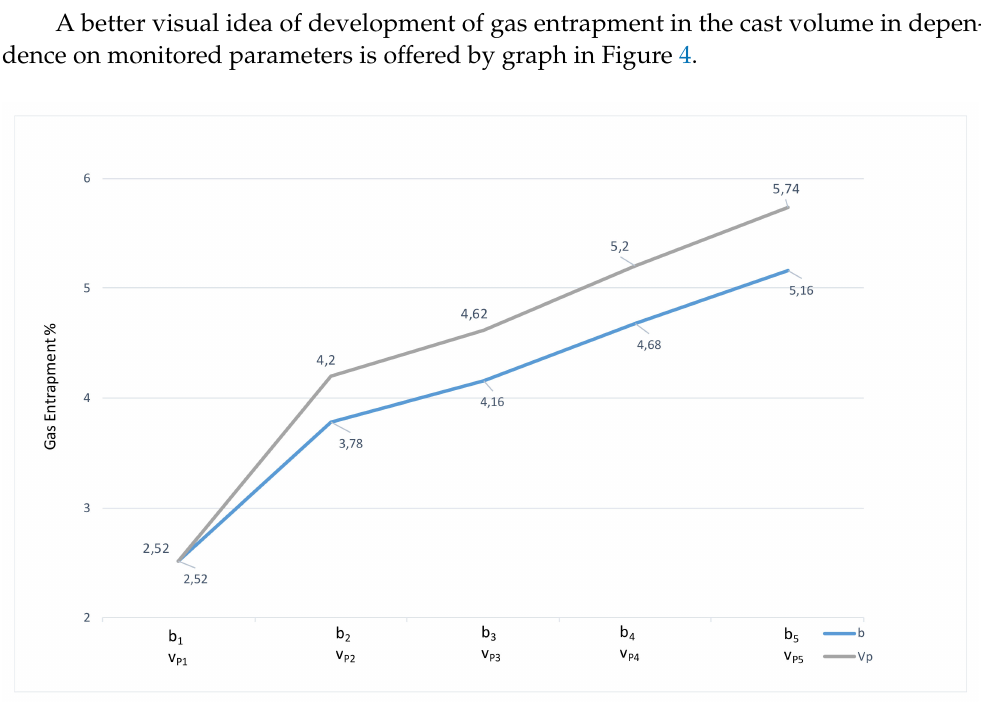
Figure 4. Gas entrapment in the cast in dependence on monitored